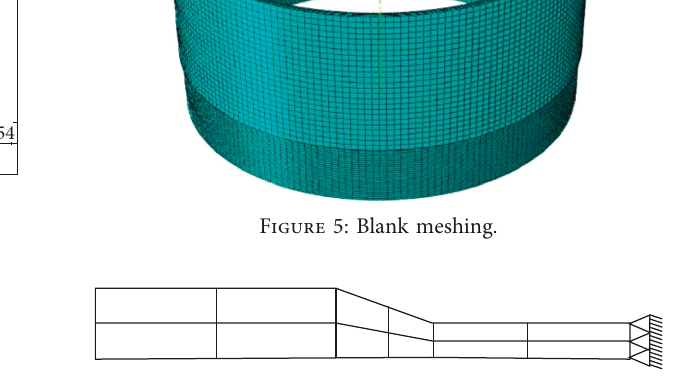
Figure 6: Three-way displacement constraint.